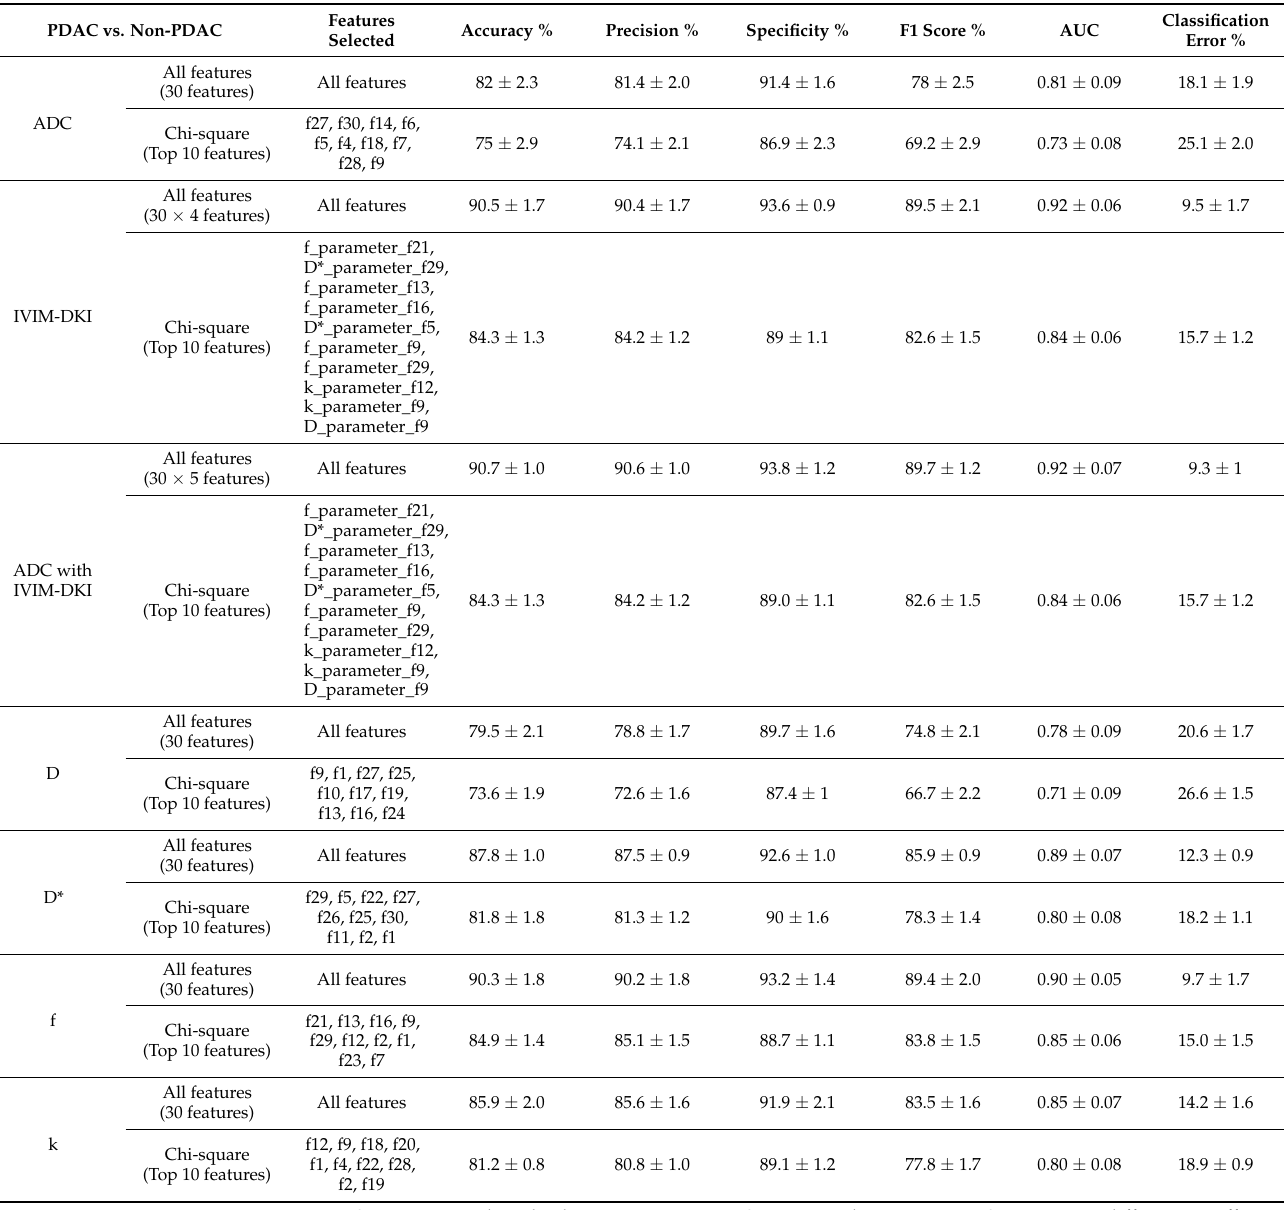
Table 5. Machine learning-based classification performance of all texture features (30 features) and top ten features selected from ADC, combined, and individual IVIM-DKI parameters, and ADC combined with IVIM-DKI parameters to classify PDAC from Non-PDAC pancreatic masses using an